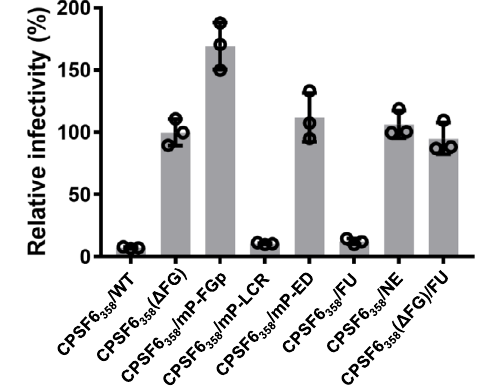
weresubstitutedwithchargedresiduesGluorAsp.CPSF6 358 /NE:theLCRsegments ofCPSF6 358 werereplacedwithnon-LCRcounterpartsfromNEURM 97-179 .CPSF6 358 / FU: the LCR segments of CPSF6 358 were replaced with alternative LCR from FUS 35- Δ FG)/FU: FG residues were deleted from CPSF6 358 /FU. b Relative 117 . CPSF6 358 ( infectivity of VSV-G pseudotyped HIV-1 in the Hela cells stably overexpressing proteins shown in a . Infectivity was normalized to CPSF6 358 ( Δ FG). The averaged data (+/ − SD) from three independent experiments are shown. Source data are provided as a Source Data fi